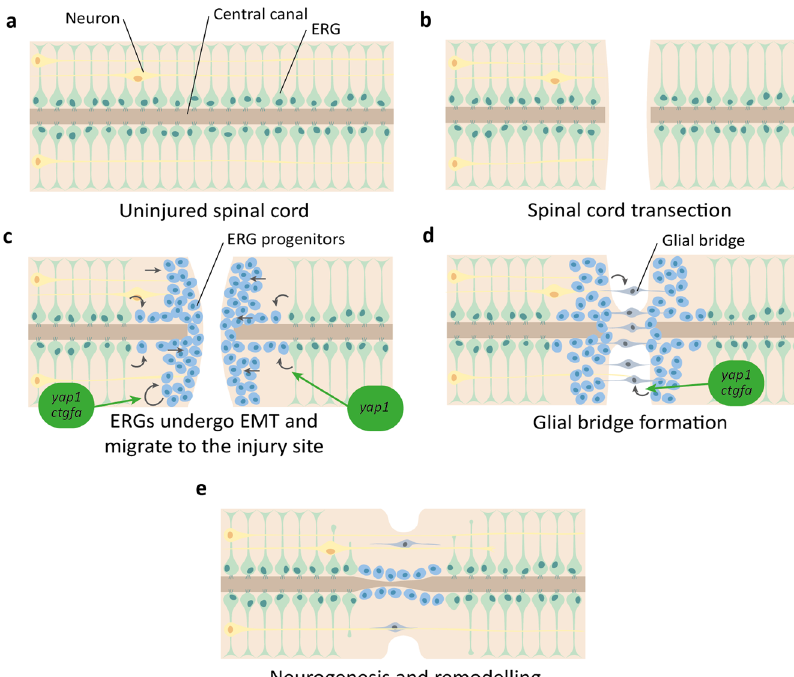
Fig. 4 Overview of zebra fi sh spinal cord regeneration. a Structure of the uninjured spinal cord, with ependymal radial glia (ERG) (green) lining the central canal and motor neurons (yellow). b Spinal cord transection disrupts neuronal processes. c ERGs undergo EMT to form ERG progenitors (blue) and migrate to the site of injury. yap1 promotes EMT of ERGs, and yap1 and ctgfa promote progenitor proliferation. d ERG progenitors extend processes across the injury site to form a glial bridge (grey). yap1 and ctgfa promote the formation of the glial bridge. e Neuronal processes extend across the injury site, guided by the glial bridge to promote remodelling and reformation of the spinal